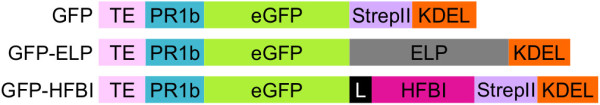
Schematic representation of constructs used to generate transgenic tobacco plants. TE, Translational enhancer from the tobacco tCUP promoter. PR1b, Secretory signal peptide from the pathogenesis related protein 1. eGFP, Enhanced green fluorescent protein. L, Linker (GGGS)3. HFBI, Hydrophobin I tag. ELP, Elastin-like polypeptide tag. StrepII, Fusion tag for detection and purification of recombinant protein. KDEL, ER retention peptide. Size of each element of the DNA constructs is not proportional to the actual sequence length [14,30].